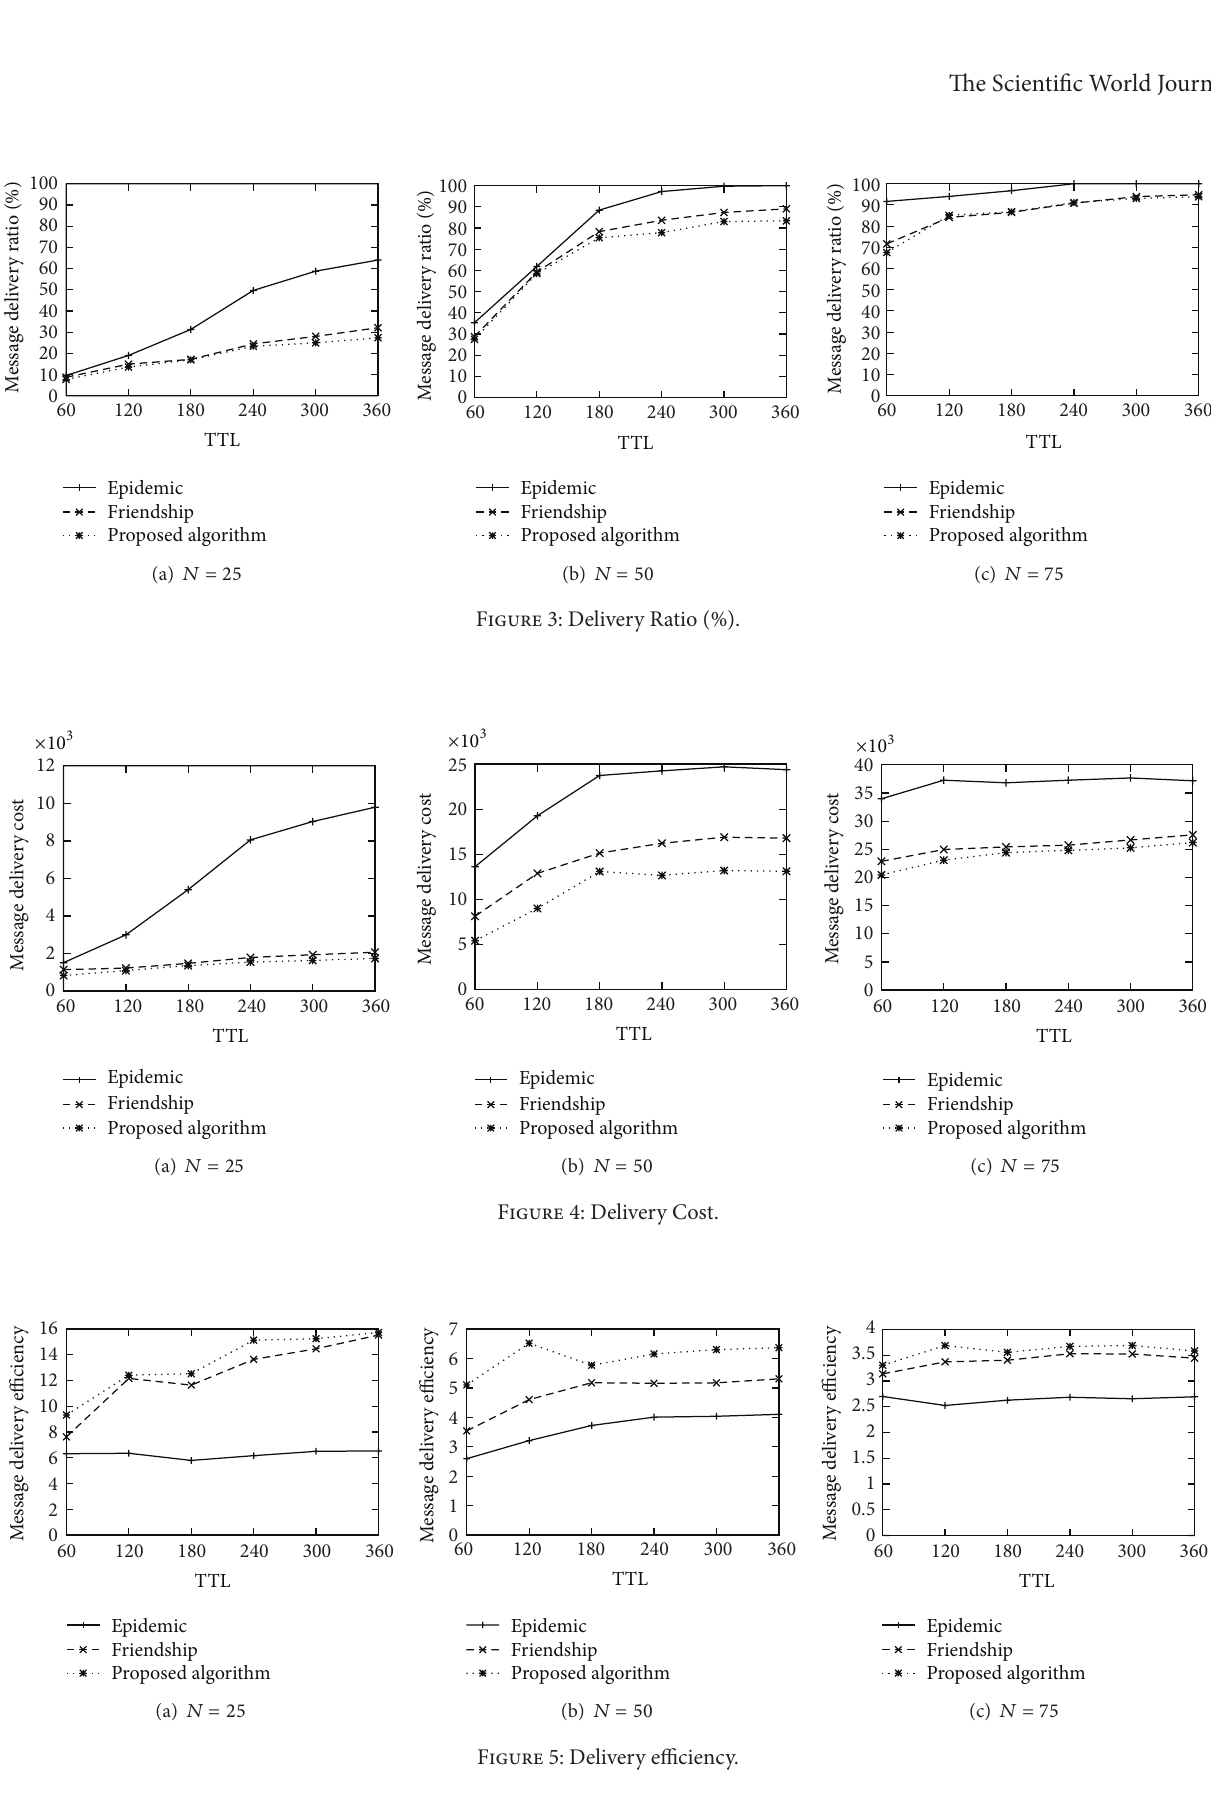
Figure 5: Delivery